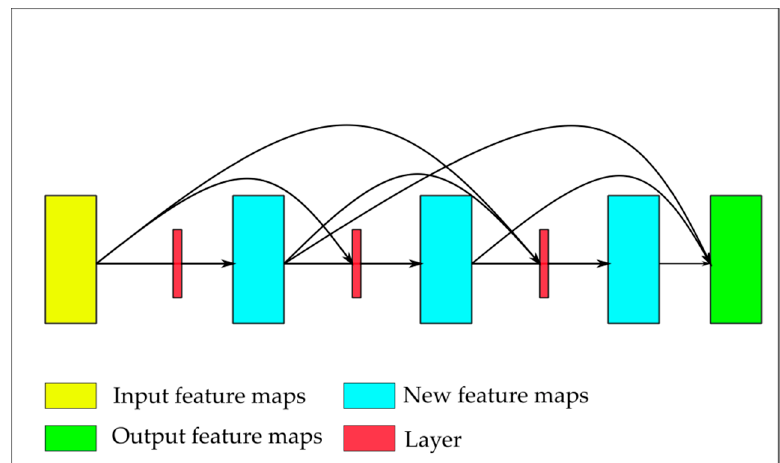
Figure 3. A dense block of the decoder in fully convolutional descent. The input of this dense block is not concatenated with the new feature maps in the final stage.